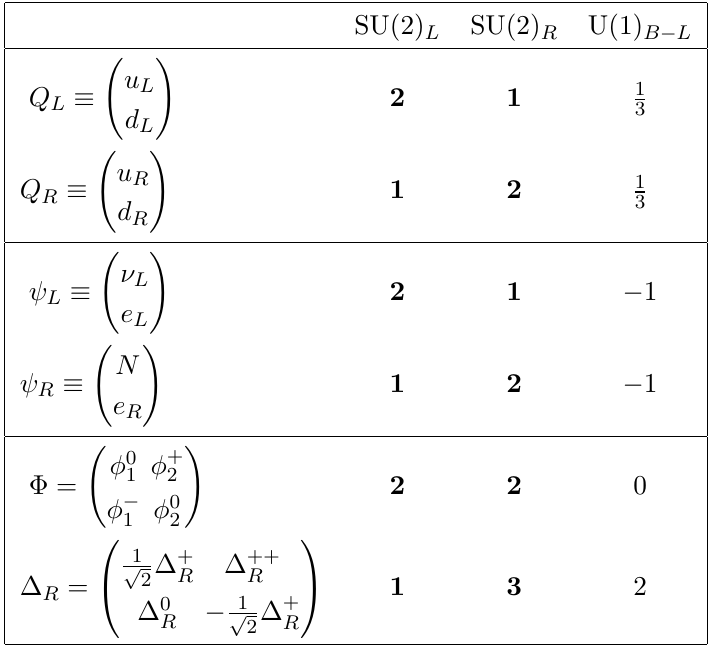
Table 3 . Particle content of the minimal LRSM based on the gauge group SU(2) L (cid:2) SU(2) R (cid:2) U(1) B (cid:0) L